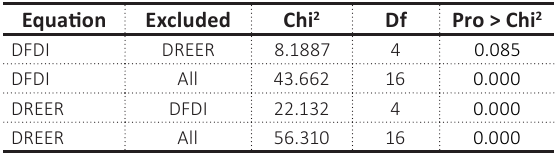
Table 5. Granger causality Wald tests